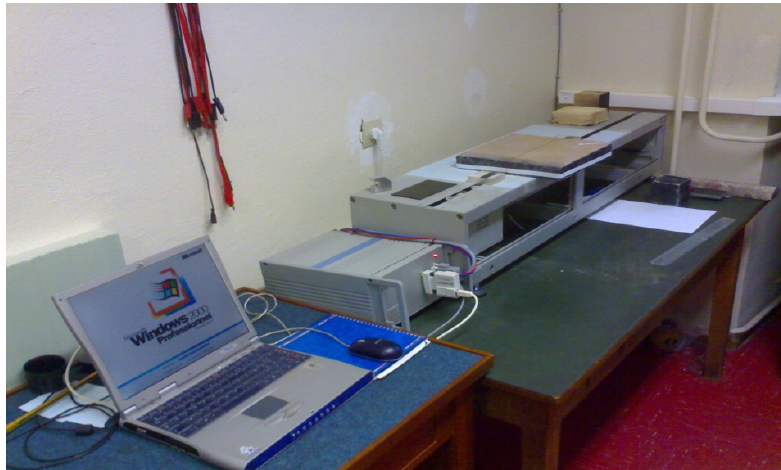
Figure 4. The thermal conductivity scanner [21,22].